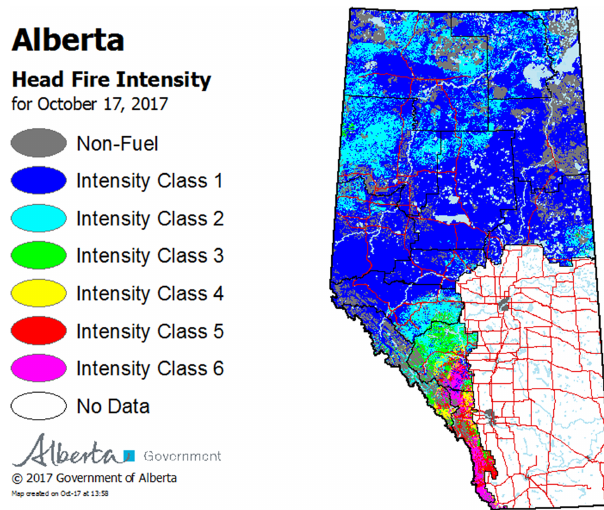
Figure 9. Wildfire intensity classes in Alberta, Canada (http:// wildfire.alberta.ca, last access: 17 October